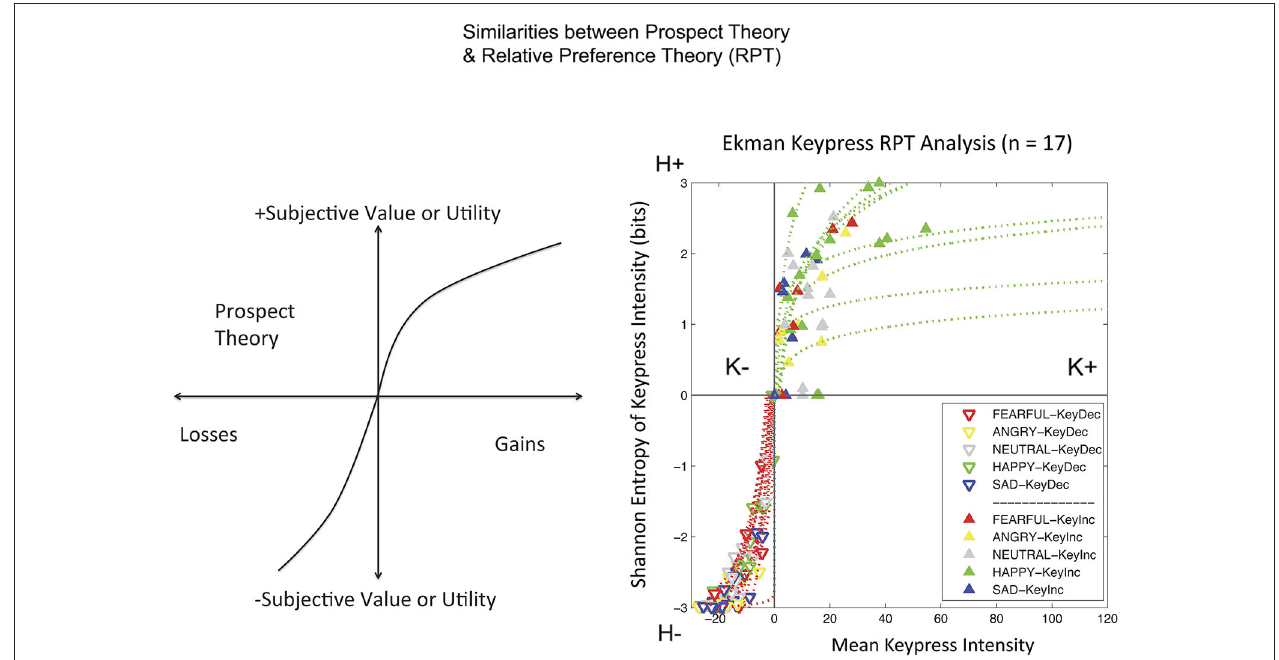
be interpreted as representing memory about the uncertainty related to making choices over this stimulus set. The approach graph is in green and the avoidance graph is in red. On the left is shown a schema for prospect theory (Kahneman and Tversky, 1979) to emphasize the similarity, despite different variables, between the two theoretical frameworks of prospect theory and relative preference theory (Breiter and Kim, 2008; Kim et al., 2010). Both show an increased slope for negative or avoidance responses relative to positive or approach